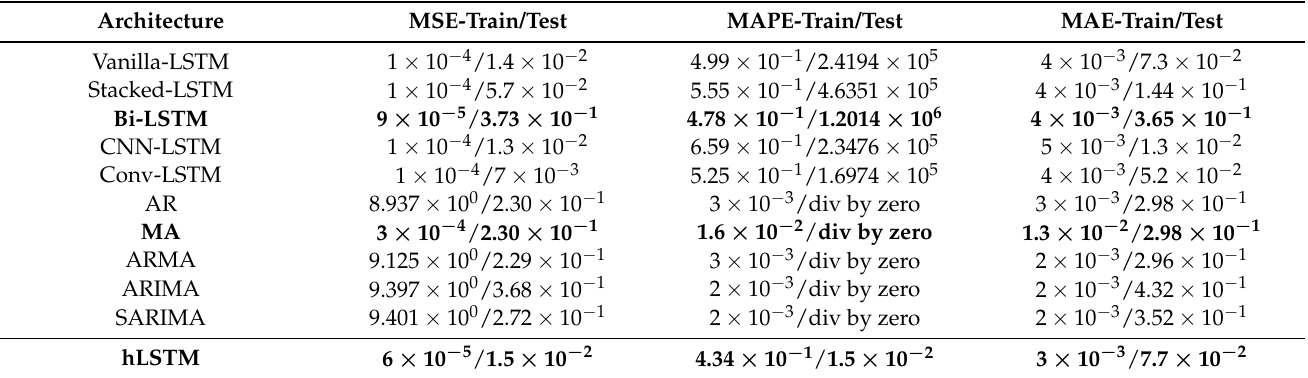
Table 3. Results of evaluation metrics for